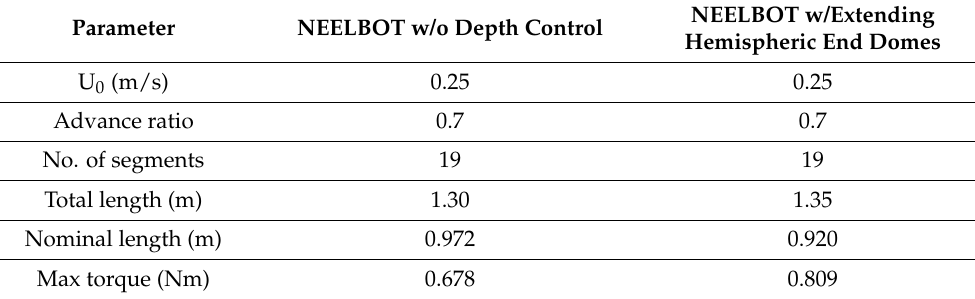
Table 1. Robot design parameters.